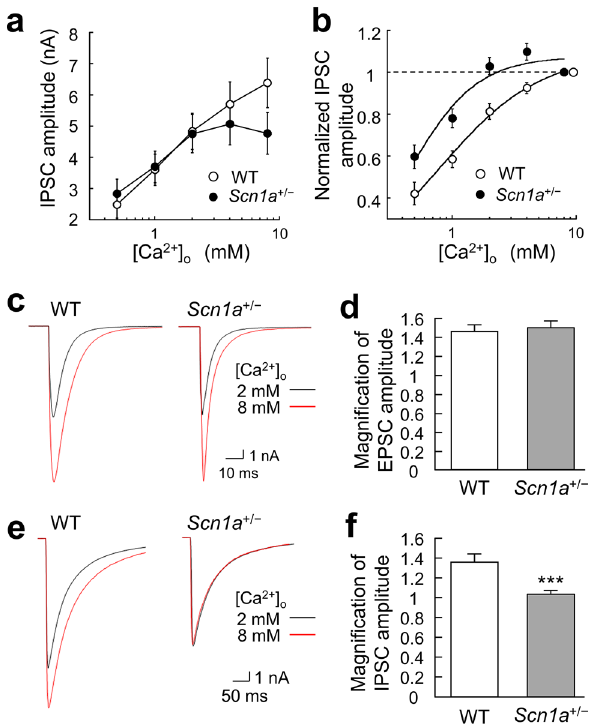
Figure 5. Changes in extracellular Ca 2+ concentration sensitivity of inhibitory synapses in Scn1a +/− neurons. ( a ) Inhibitory postsynaptic current (IPSC) amplitudes recorded in different extracellular [Ca 2+ ] o (0.5, 1, 2, 4, 8 mM) with 1 mM Mg 2+ held constant in wild-type (WT) and Scn1a +/− neurons (WT: n = 35, Scn1a +/− : n = 36/ N = 9 cultures). ( b ) Dose–response curves and Hill fits for normalized IPSC amplitudes, recorded in different extracellular [Ca 2+ ] o (0.5, 1, 2, 4, 8 mM) with 1 mM Mg 2+ , held constant in WT and Scn1a +/− neurons. IPSC amplitudes were normalized to the IPSC amplitude at 8 mM [Ca 2+ ] o . Original data were obtained from the same cells as in ( a ). ( c ) Representative traces of evoked excitatory postsynaptic currents (EPSCs) recorded at 2 mM [Ca 2+ ] o (black line) and 8 mM [Ca 2+ ] o (red line) from neurons of either WT or Scn1a +/− mice. Depolarization artifacts caused by the generated action currents have been removed for clarity of presentation. ( d ) Average magnification of evoked EPSCs at 8 mM [Ca 2+ ] o based on EPSC amplitudes at 2 mM [Ca 2+ ] o in neurons of WT or Scn1a +/− mice (WT: 1.45 ± 0.07, n = 62, Scn1a +/− : 1.48 ± 0.07, n = 64/ N = 11 cultures). ( e ) Representative traces of evoked IPSCs recorded at 2 mM [Ca 2+ ] o (black line) and 8 mM [Ca 2+ ] o (red line) from neurons of either WT or Scn1a +/− mice. Depolarization artifacts caused by the generated action currents have been removed for clarity of presentation. ( f ) Average magnification of the evoked IPSCs at 8 mM [Ca 2+ ] o based on IPSC amplitudes at 2 mM [Ca 2+ ] o in neurons of WT or Scn1a +/− mice (WT: 1.36 ± 0.09 mM, n = 35, Scn1a +/− : 1.02 ± 0.04 mM, n = 36/ N = 9 cultures, *** p <